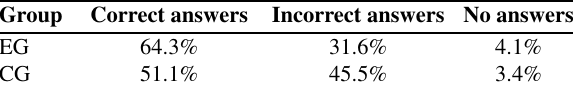
Table 3. Formation of propene (reactant 1-chloropropane), percen- tages of correct and incorrect answers. Group